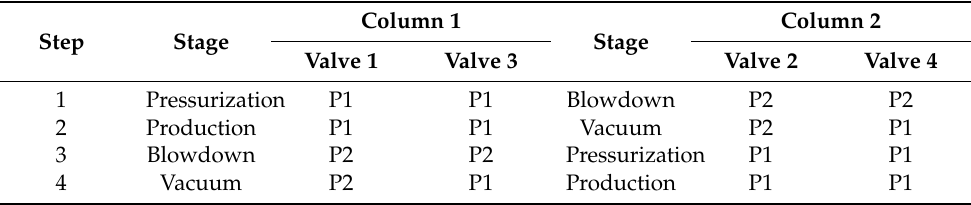
Table 1. The valve operation sequence for the PVSA cycle.